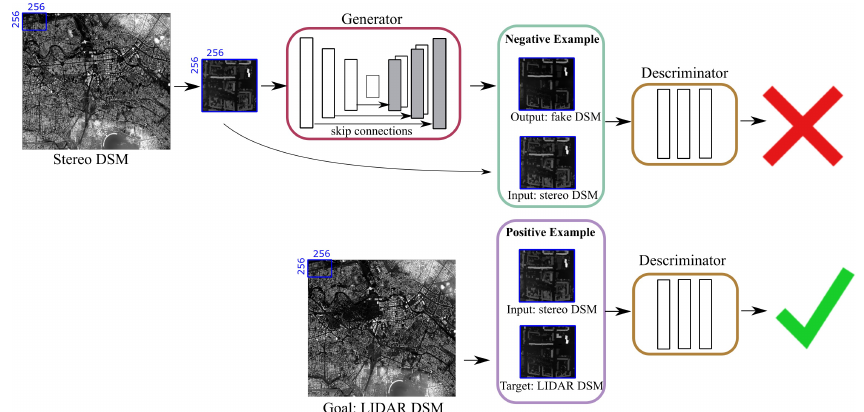
Figure 1. Schematic overview of the proposed method for the 3D building shape improvement in stereo digital surface model (DSM) by conditional generative adversarial network (cGAN)